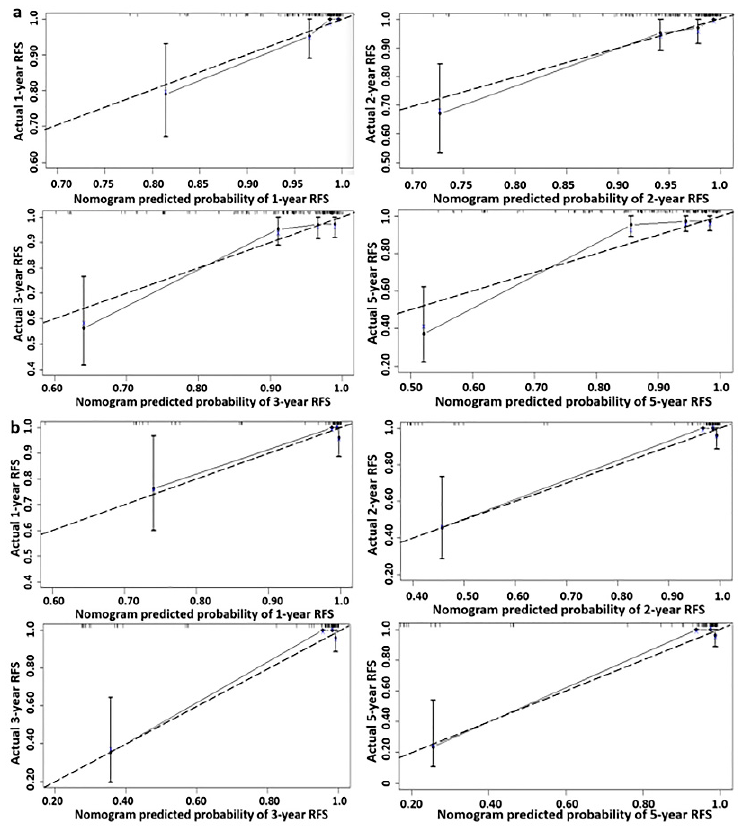
Figure 2. ( a ) The calibration curves of this nomogram model for predicting recurrence-free survival of neuroendocrinal carcinoma of cervix in the training cohort. ( b ) The calibration curves of this nomogram model for predicting recurrence-free survival of neuroendocrinal carcinoma of cervix in the validated cohort. (The dotted line: reference line. The solid line: the prediction curve provided by the nomogram